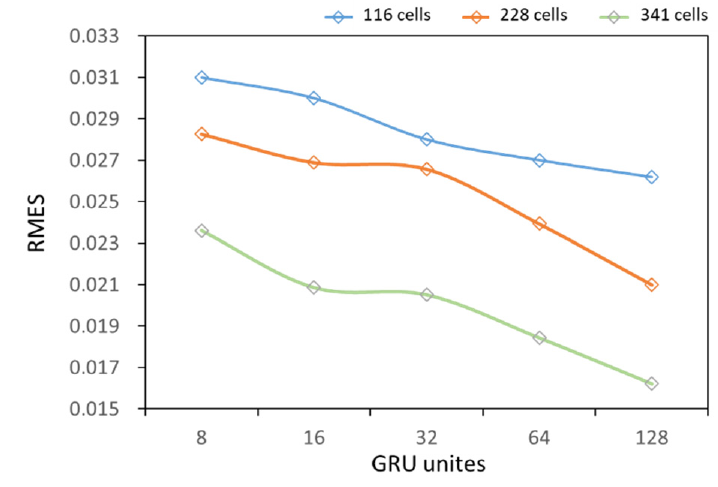
Figure 12. Predictive accuracy versus the number of hidden units.